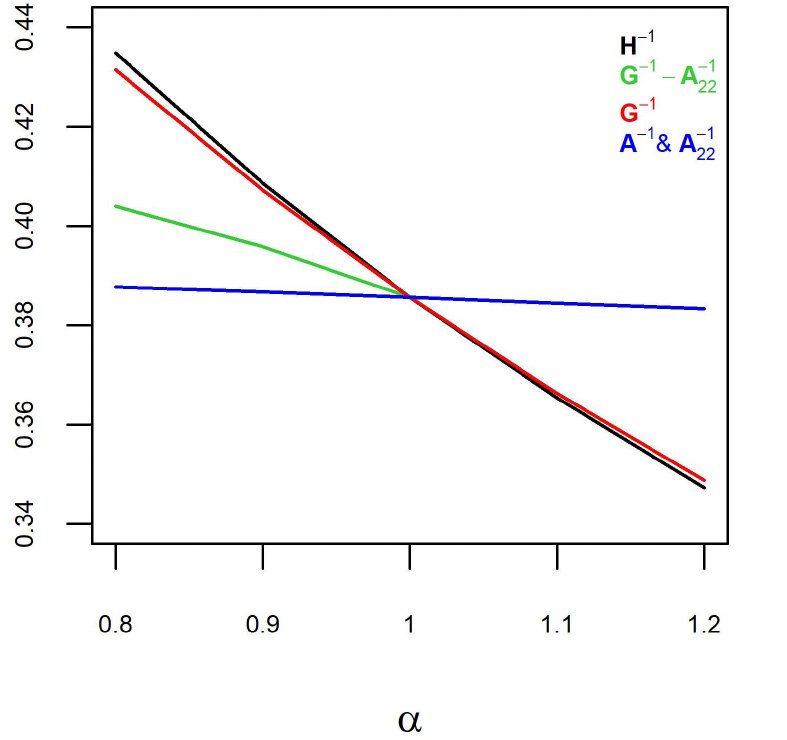
Figure 2. Correlation coefficients between phenotypes and genomic breeding values for different components of H − 1 weighted by α . Each data point is an average of ten observations for the simulated